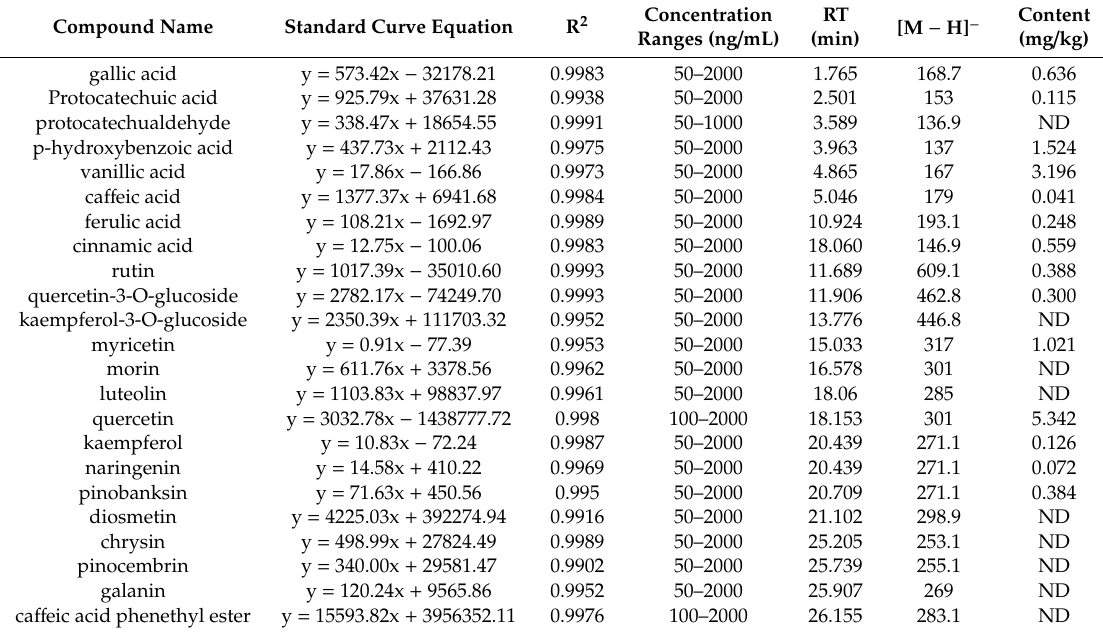
Table 4. High-performance liquid chromatography combined with a quadrupole time-of-flight mass.